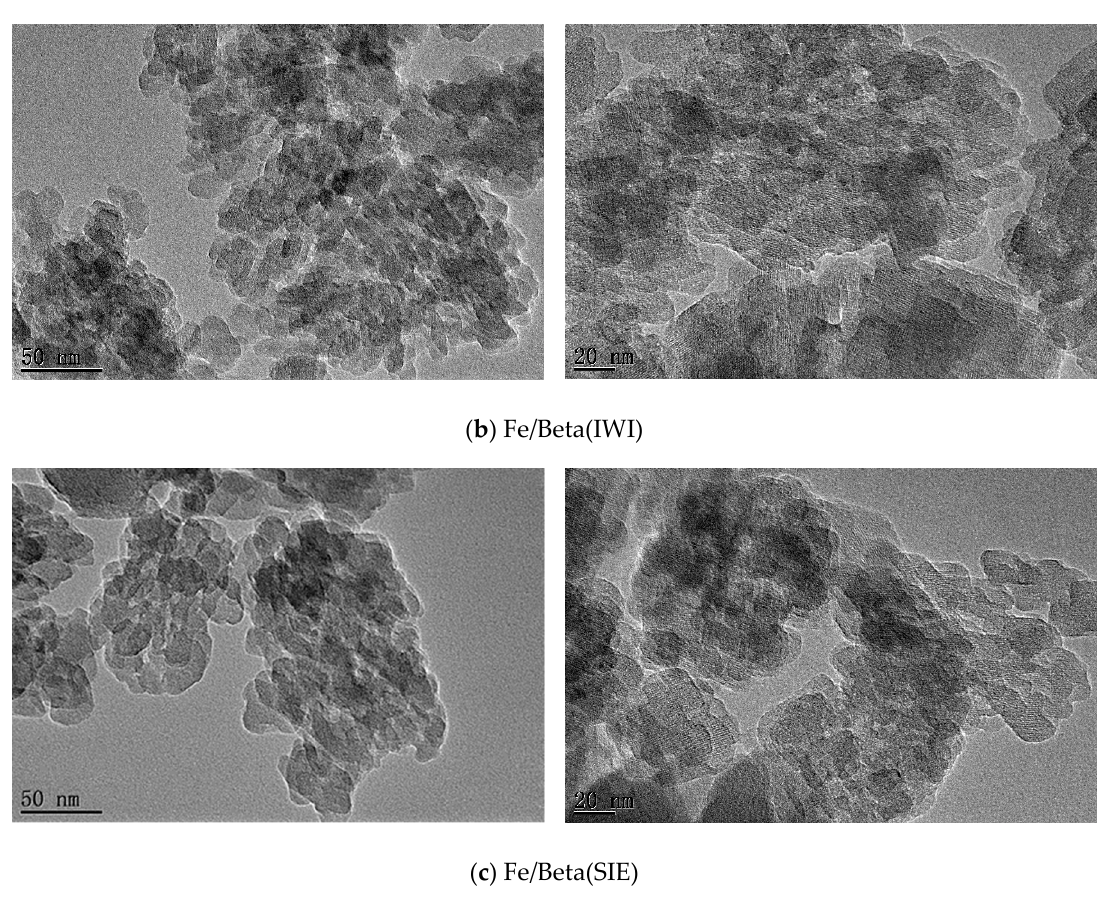
Figure 3. TEM images of Fe/Beta catalysts.